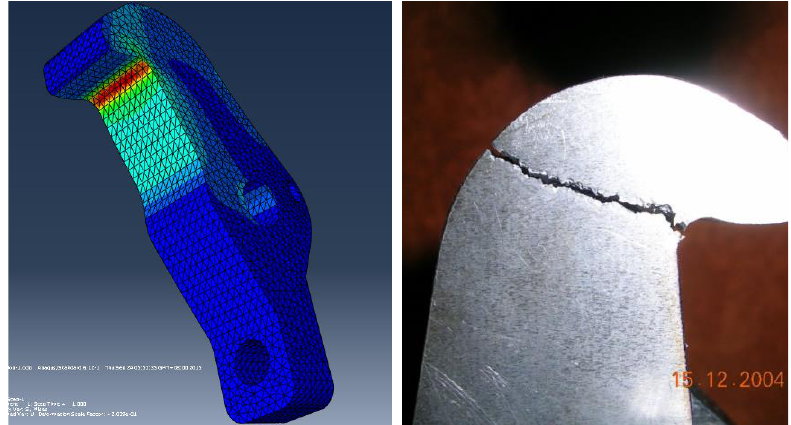
Figure 4. The stress nephogram and test result for the structural latch.